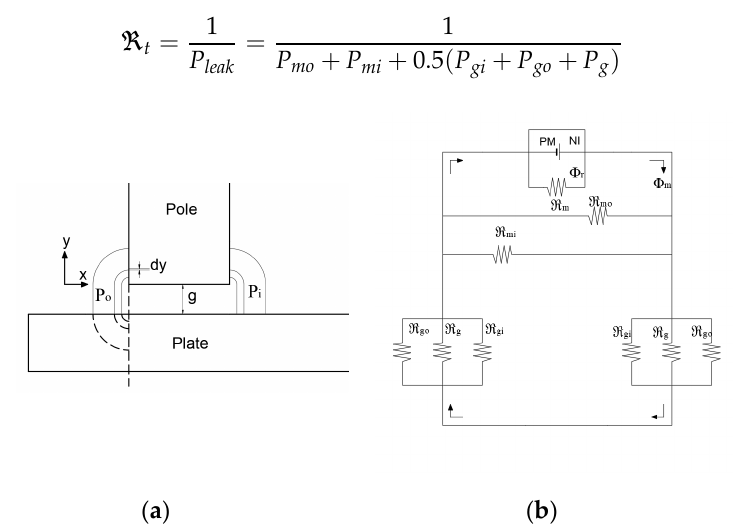
Figure 4. Magnetic circuit modeling: ( a ) Path models for the leaked flux; ( b ) Equivalent magnetic circuit.